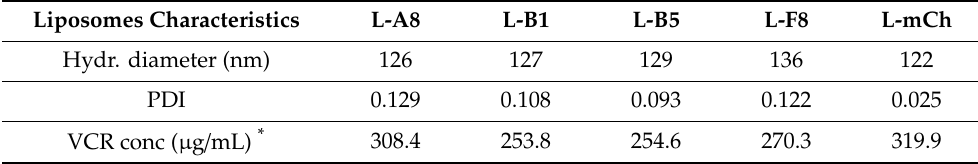
* VCR end concentrations of the five formulations were determined by